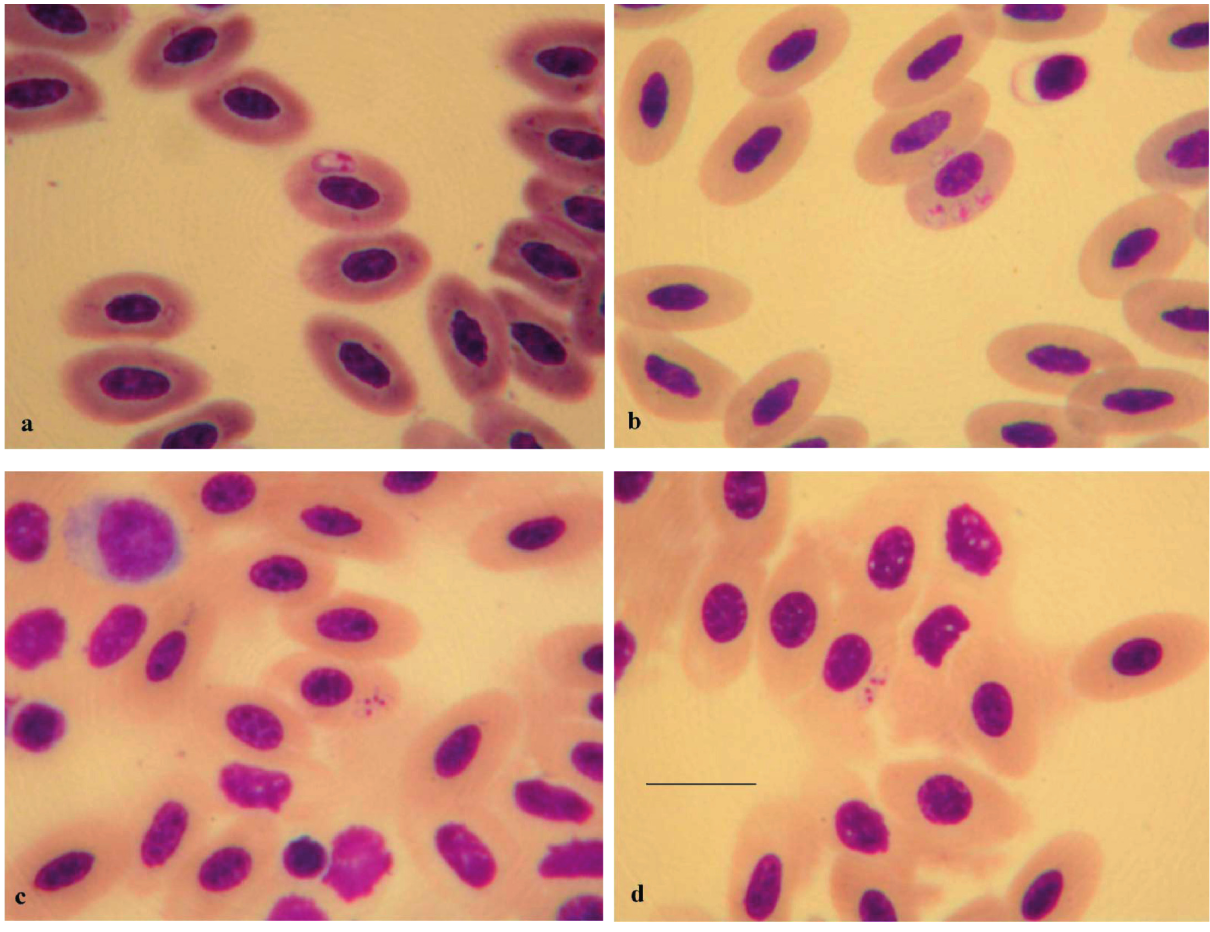
Fig. 1. – Babesia ugwidiensis sp. nov. from Phalacrocorax carbo